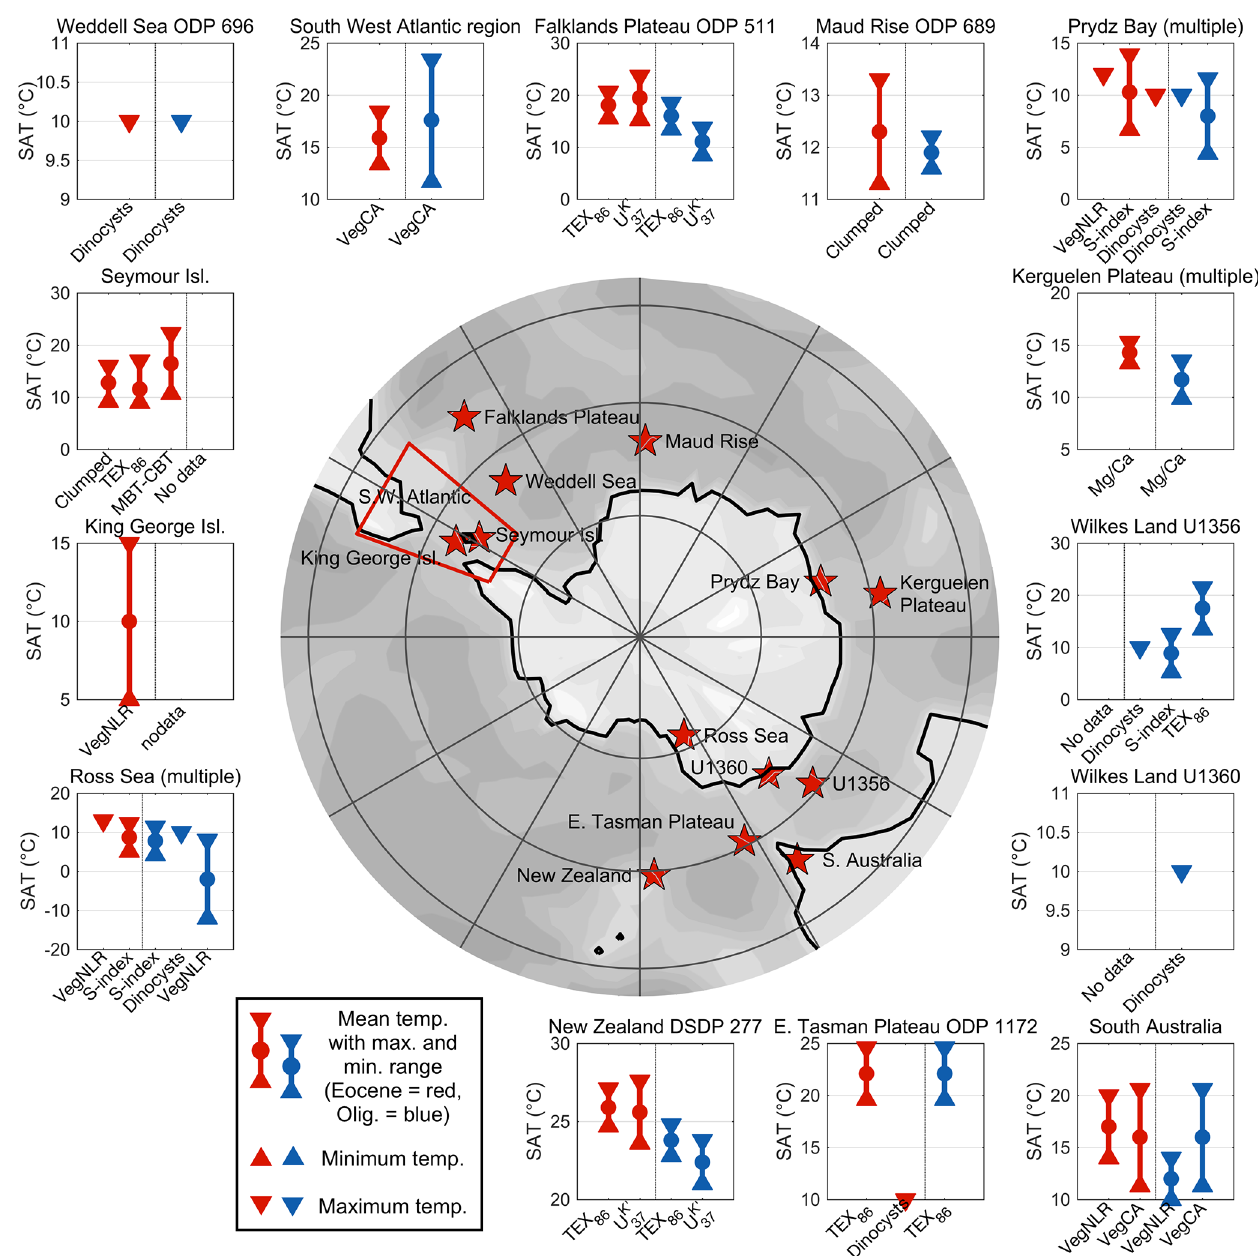
Figure 1. Mean annual temperature ( ◦ C) from proxy records for all sites during the late Eocene and early Oligocene. The mean values (circles) are shown with maximum and minimum values (error bars), while ordinal limits are shown by upward-pointing (greater than) or downward-pointing (less than) triangles. Late Eocene records are in red and early Oligocene records in